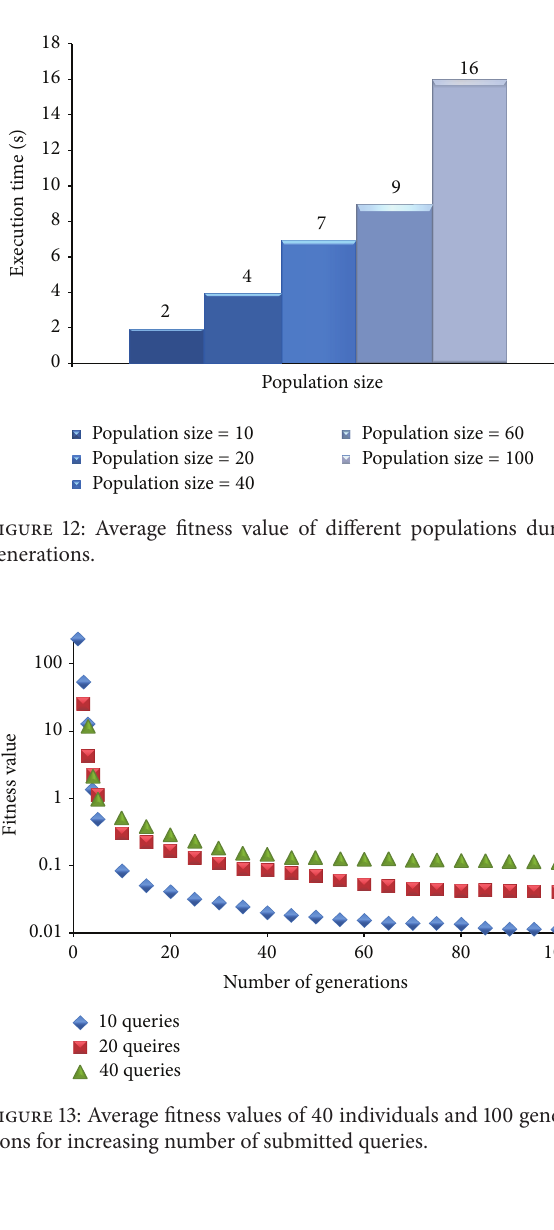
Table 9: Parameter settings for multiobjective genetic